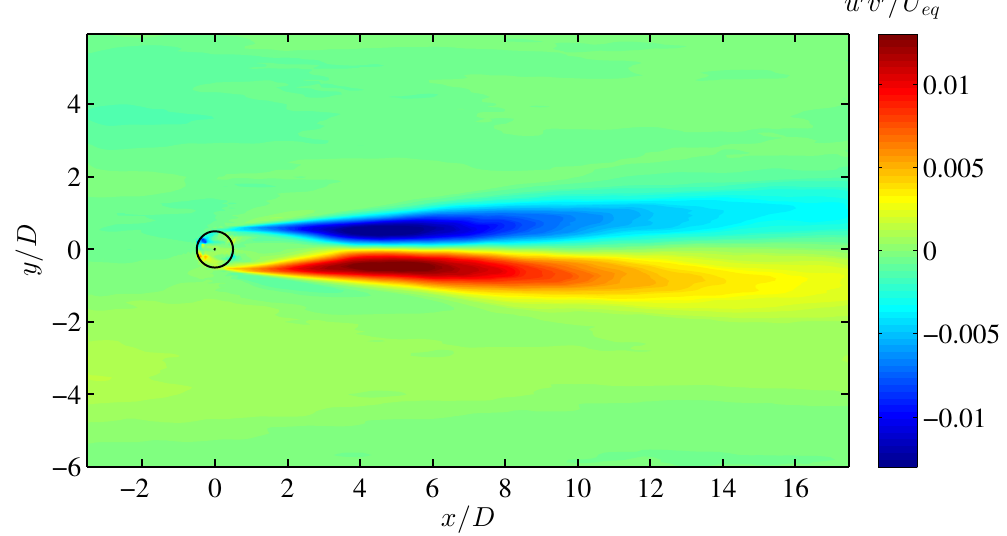
Figure 15. Contour plot of the normalized lateral turbulent flux, u (cid:48) v (cid:48) / U eq 2 , in the x - y plane at the equator height of the